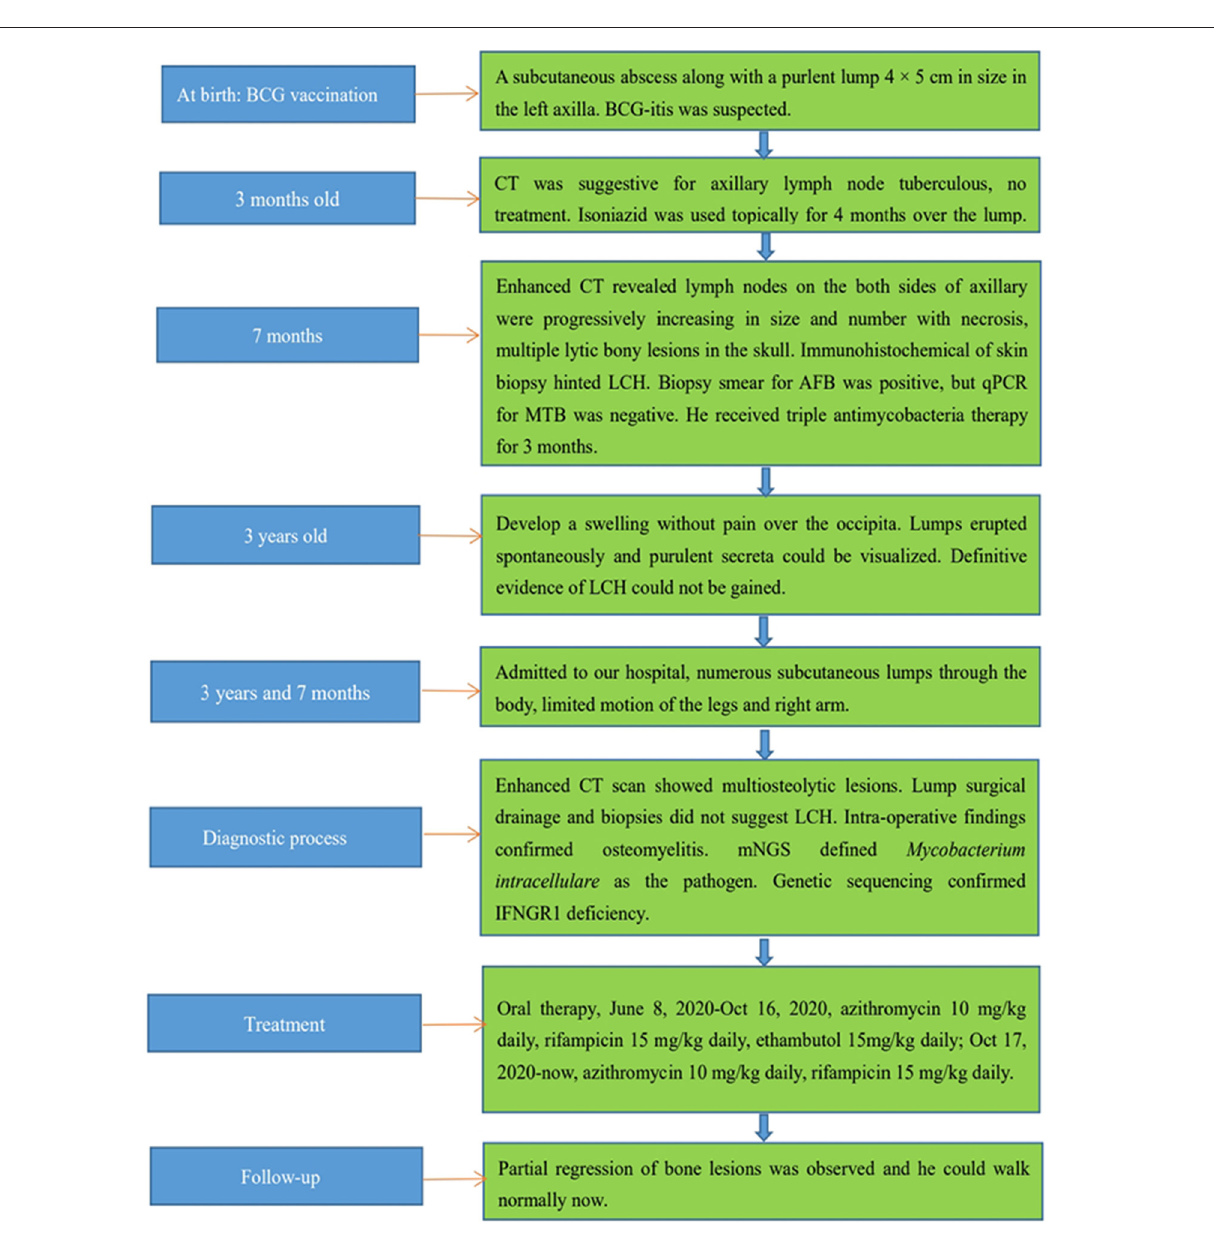
FIGURE 4 | Clinical course of the